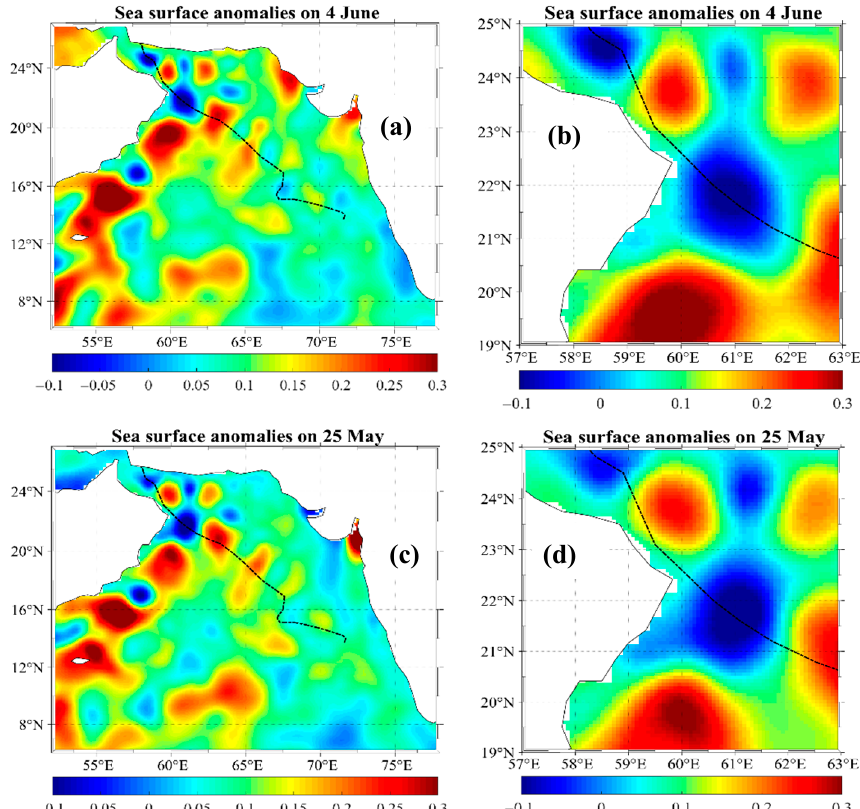
Figure 10. ( a , c ) Sea surface height anomaly (in m) on 25 May and 4 June, respectively, over the Arabian Sea and Gulf of Oman. ( b , d ) Close-up view of Ras al Hadd and its offshore regions.